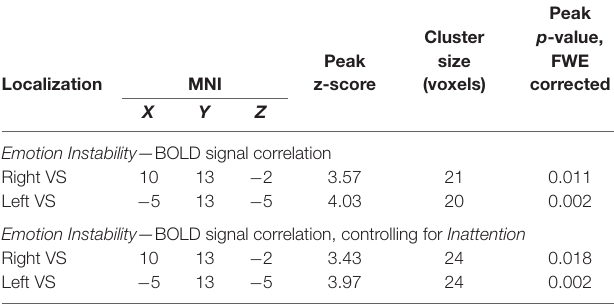
TABLE 1 | Correlations of Emotion Instability and BOLD signal within the bilateral VS during reward anticipation in females.